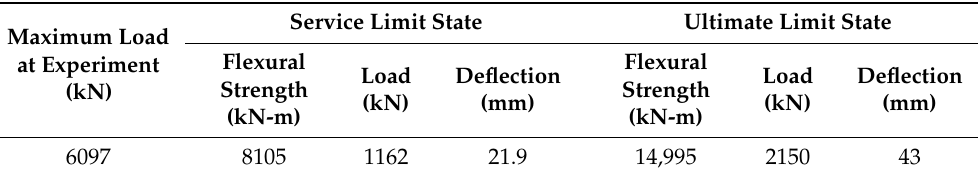
Table 6. Section forces and loads according to limit